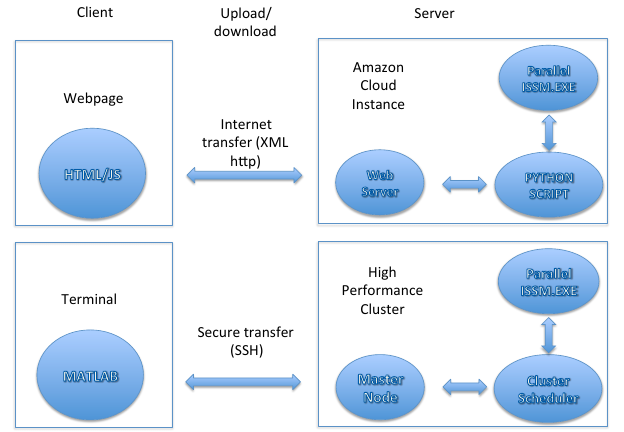
Figure 2. Similarities between a standard ISSM run from a terminal running MATLAB and connected to a HPC cluster and a web-based ISSM run from a web page running JavaScript, connected to a web server running on an Amazon EC2 cloud instance. In the first case (lower frames), a MATLAB instance running on a local workstation marshalls a binary file, which is then uploaded (using an SSH call) to a master node on a cluster. The binary file is then queued into the system (using a qsub command from a scheduler, for example). The parallel runs are then carried out using the ISSM executable and an MPI-compatible environment. In the second case, a browser client makes an XMLHttpRequest and uploads a Binary Large Ob- ject (the exact same binary file MATLAB would upload), which is received by an HTTP server (e.g., Apache) running on an Ama- zon EC2 compute-optimized instance. The HTTP server then uses a FastCGI module to interface to a Python wrapper, which auto- matically triggers a system call to the MPI environment running the ISSM executable. In both cases, an output binary file is created by the ISSM executable, which is then shipped back to the MATLAB instance or the client’s web